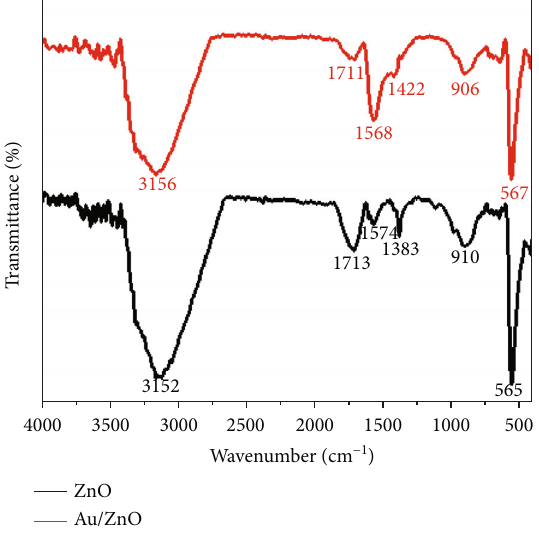
Figure 6: IR spectra of bare ZnO and Au/ZnO-5